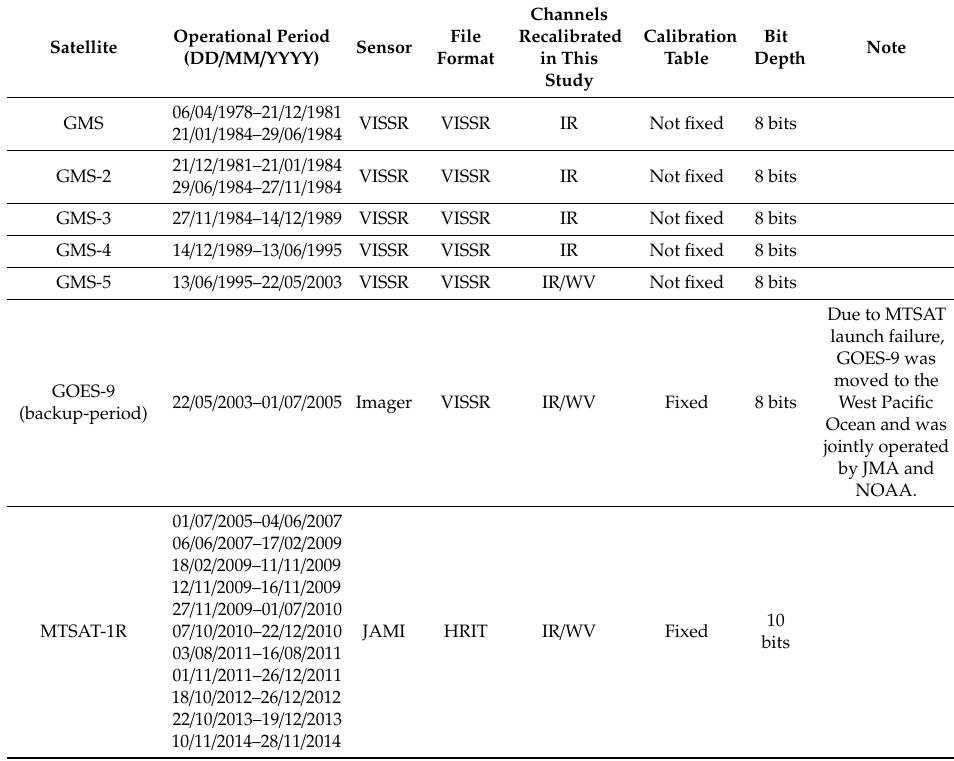
Table 1. Overview of Japan Meteorological Agency’s (JMA’s) historical geostationary satellites and sensors. File format, calibration table and bit depth are described for the archived data in